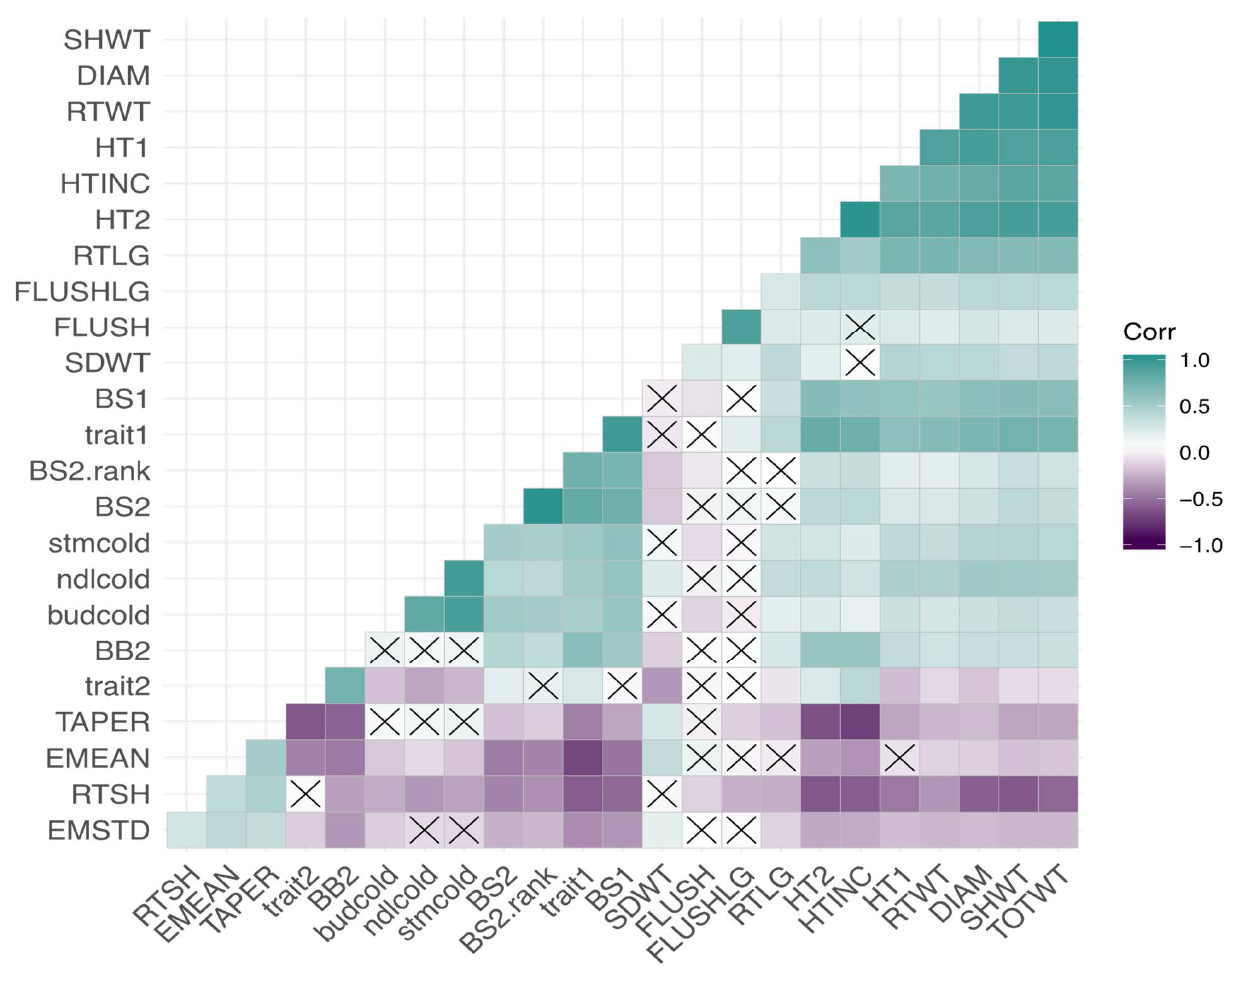
Figure A2. Correlations among phenotypes. A heatmap is shown with a gradient between purple (negative correlation coefficient) and teal (positive correlation coefficient) with white representing a correlation coefficient of zero. No significant correlations are denoted by an “×” in each box. Phenotypes’ IDs can be found in Table A1.